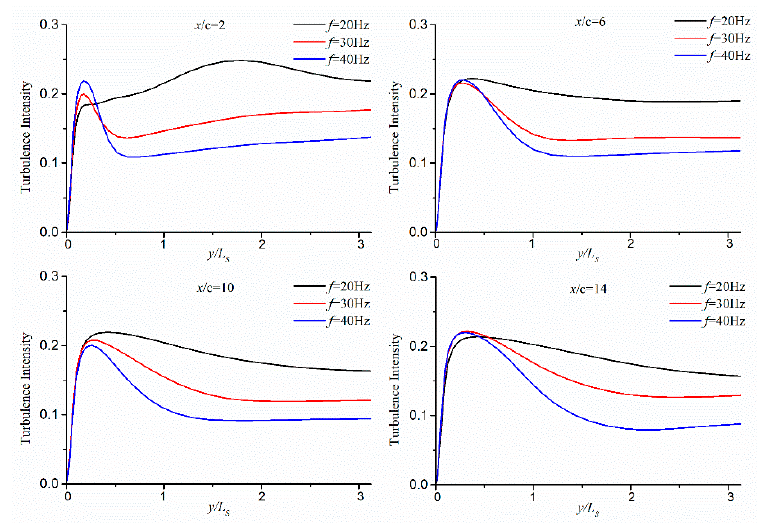
ff erent streamwise